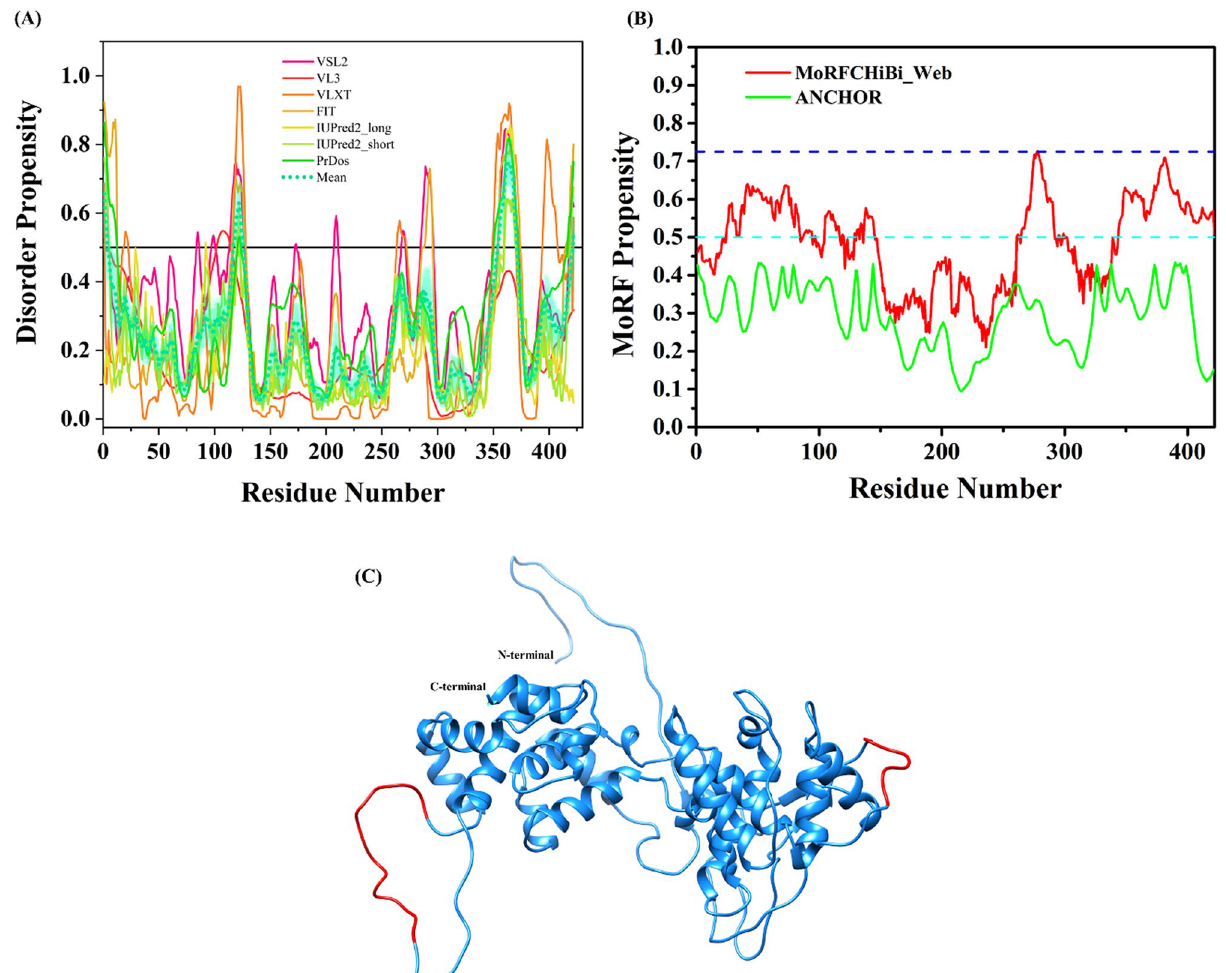
Figure 4. Intrinsic disorder predisposition of Nucleoprotein (N). ( A ) The intrinsic disorder profile generated for Nucleoprotein by a set of disorder predictors; PONDR VSL2, PONDR VL3, PONDR VLXT, PONDR FIT, IUPred2_long, and IUPred2_short are represented by black, red, blue, magenta, dark yellow-, and navy-colored straight lines respectively. A mean disorder profile calculated by averaging the outputs of seven predictors is represented by the green-colored short-dash line. Light green region around mean curve represents the error distribution for the mean. ( B ) MoRFs prediction through MoRFCHiBi_Web and ANCHOR. Dashed cyan line (0.5) represents cut-off for ANCHOR and dashed blue line (0.725) represents cut-off for MCW server. The area with light magenta color represents MoRF region predicted by MCW server. ( C ) Full-length modelled structure for N protein using I-Tasser web server. Red colored regions are predicted to be disordered based on the calculated mean. The N- and C-terminals are shown with arrows in the